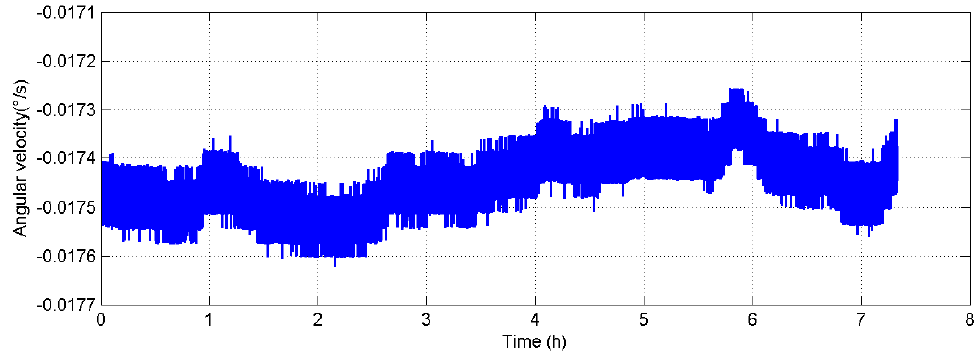
Figure 5. Raw data of the comagnetometer.